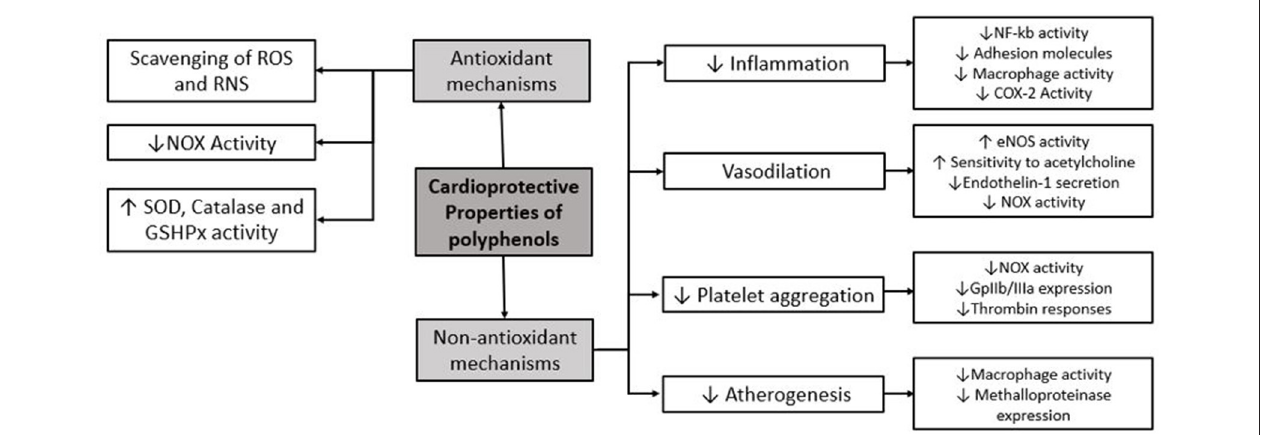
FIGURE 1 | Main molecular mechanisms of protective effects of polyphenols. ROS, reactive oxygen species; RNS, reactive nitrogen species; NOX, NADPH oxidase; SOD, superoxide dismutase; GSHPx, glutathione peroxidase; COX-2,